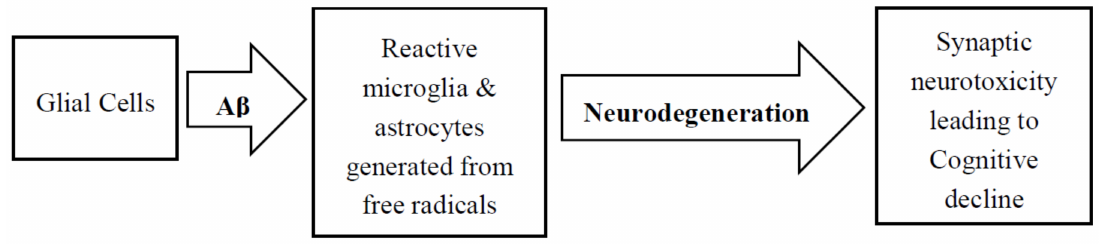
Figure 3. Neurodegeneration resulting from A β activation of glial